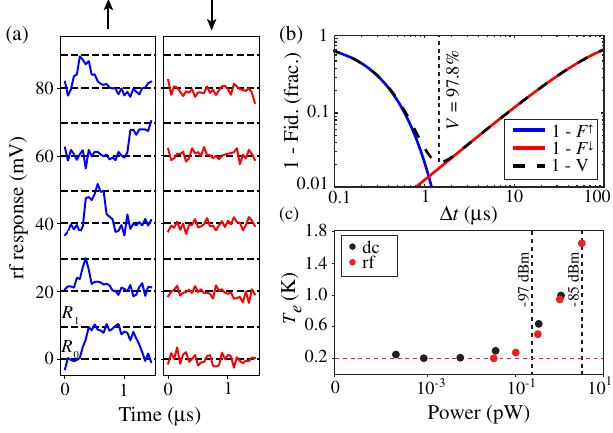
FIG. 3. μ s electron spin readout. (a) Single-shot spin readout is performed in a global magnetic field B ¼ 1 . 5 T by pulsing gate voltages to read spin states via energy selective tunneling. Each readout trace is declared spin-up or -down, respectively, if the detector response rises above a set threshold (blue, spin-up) or not ¼ 1 . 5 μ s. (red, spin-down) during the optimal readout time Δ t opt Traces are offset for clarity with pairs of dotted lines depicting R 0 and R 1 . (b) The readout time Δ t is varied to optimize state fidelities ( F ↑ and F ↓ for j ↑ i and j ↓ i , respectively) and visibility ( V ) and is optimal at 1 . 5 μ s, where V ¼ 97 . 8% . (c) Increasing the rf-input power increases T above 200 mK. When scaled to e absolute applied power, heating due to dc current (black dots) and rf-input power (red dots) shows the same trend. Black dotted lines mark the optimal powers used for charge detection ( − 85 dBm) and spin readout ( − 97